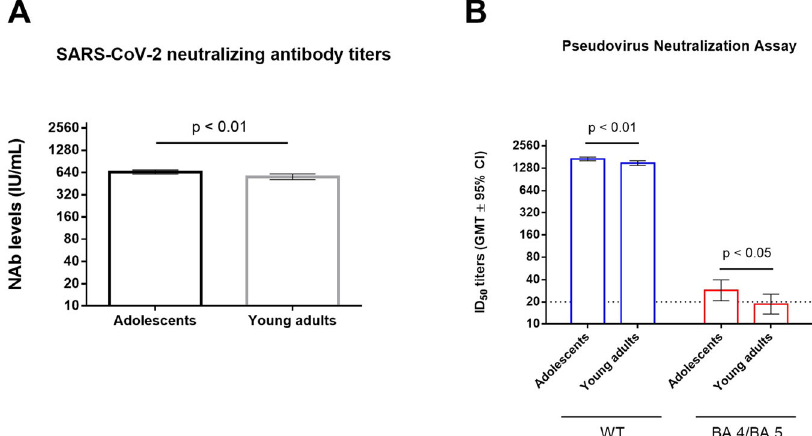
Fig. 3 Neutralizing assay results of adolescent and young adult groups. Twenty-eight days after the second dose, serum samples were taken and subjected to the ( A ) live-SARS-CoV-2 and ( B ) pseudovirus neutralization assays. The ancestral Wuhan (WT) strain was used in both the live virus and pseudovirus assay, while Omicron BA.4/BA.5 was only used in the pseudovirus assay. The results are expressed as symbols representing GMT, and error bars represent 95% con fi dence intervals. The dotted line in ( B ) represents the limit of detection of